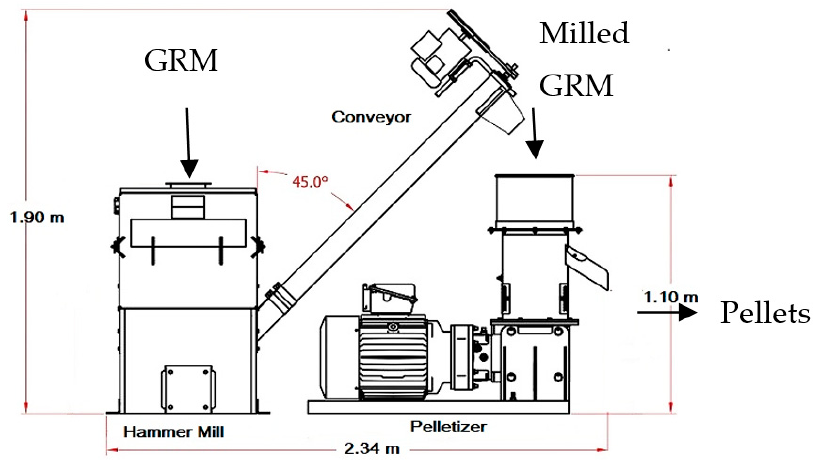
Figure 4. Pelletization pilot plant. The hammer mill was fed at the upper side with dried GRM, milled GRM was transported through the conveyor to the Pelletizer (PM1230), and pellets were collected and sealed in PE bags under vacuum.